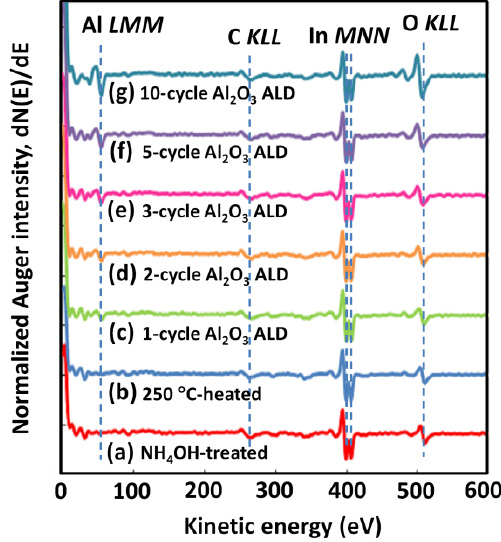
Figure 2. In situ AES analysis of the InGaAs(100) surface at energies between the Al LMM and O KLL intensities, normalized to the In MNN intensity, after NH heating at 250 °C, and integrated ALD cycles of 1, 2, 3, 5, and